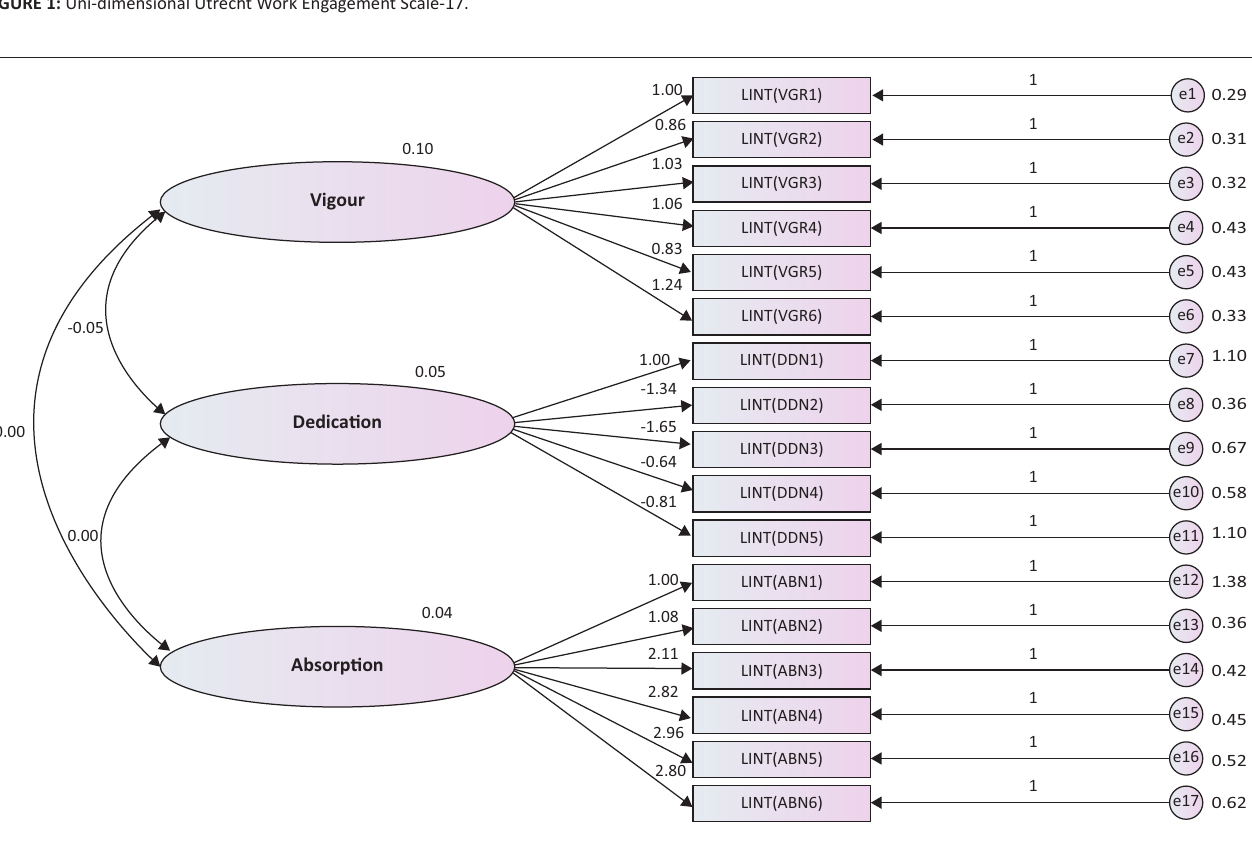
FIGURE 1: Uni-dimensional Utrecht Work Engagement Scale-17.